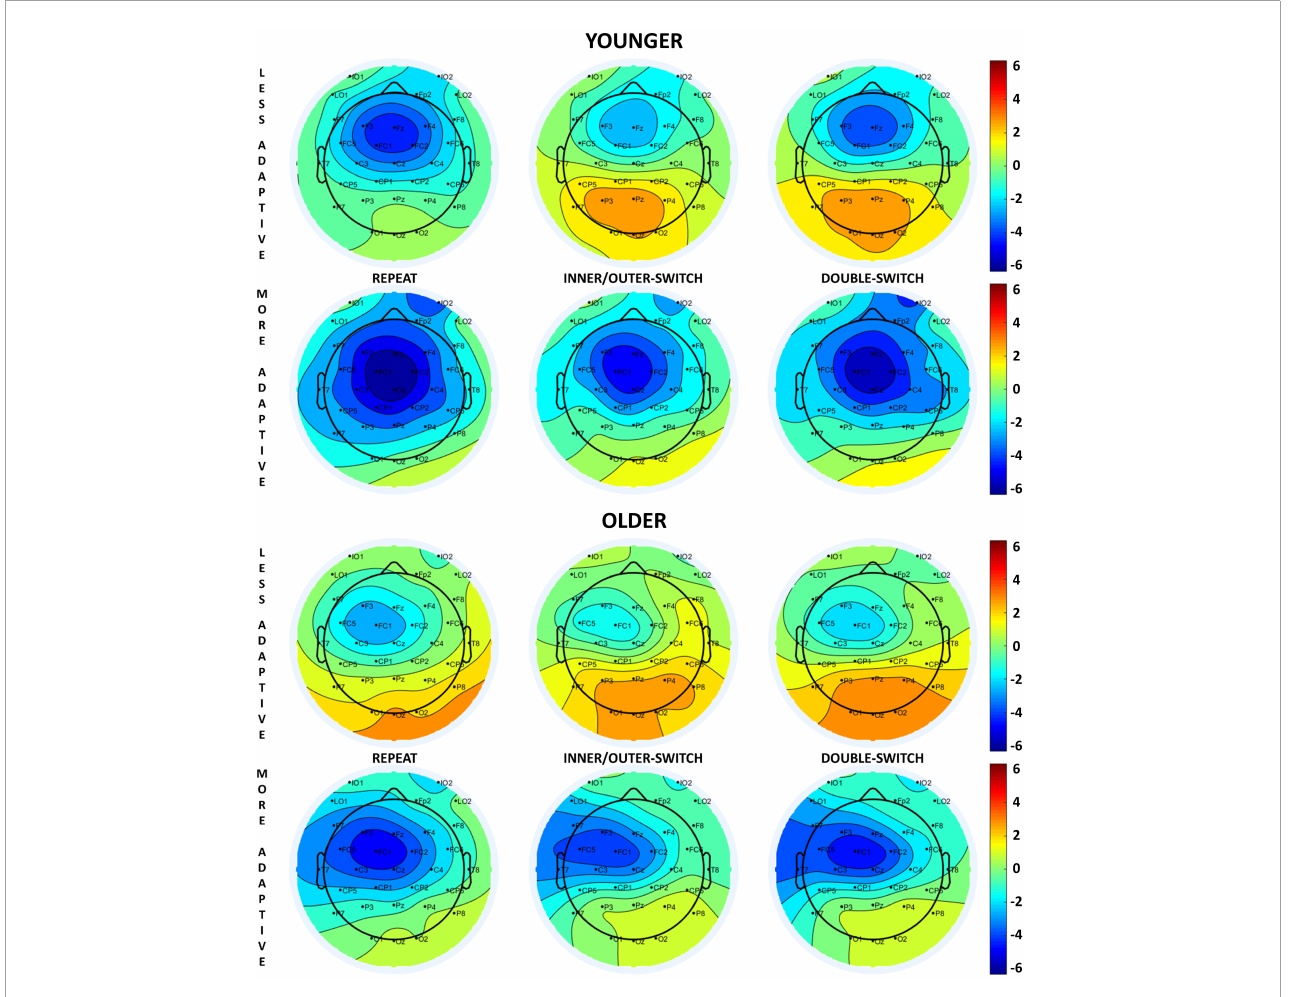
FIGURE3 Scalp distributions of the cue-locked contingent negative variation (CNV) component at 650 ms relative to the presentation of the cue stimuli for each Switch-type in the adaptive creativity